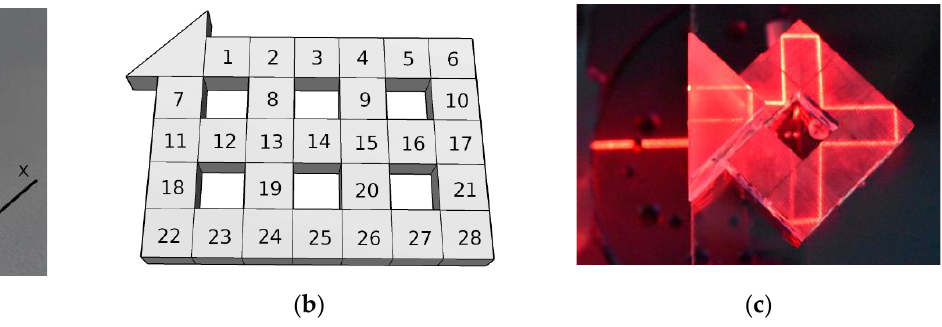
Figure 1. ( a ) The prism resonator made of quartz glass with a refractive index of 1.43. ( b ) A model of the tiling photonic topological insulator (TPhTI) composed of 28 prism resonators. ( c ) The TPhTI, composed of seven prism resonators.